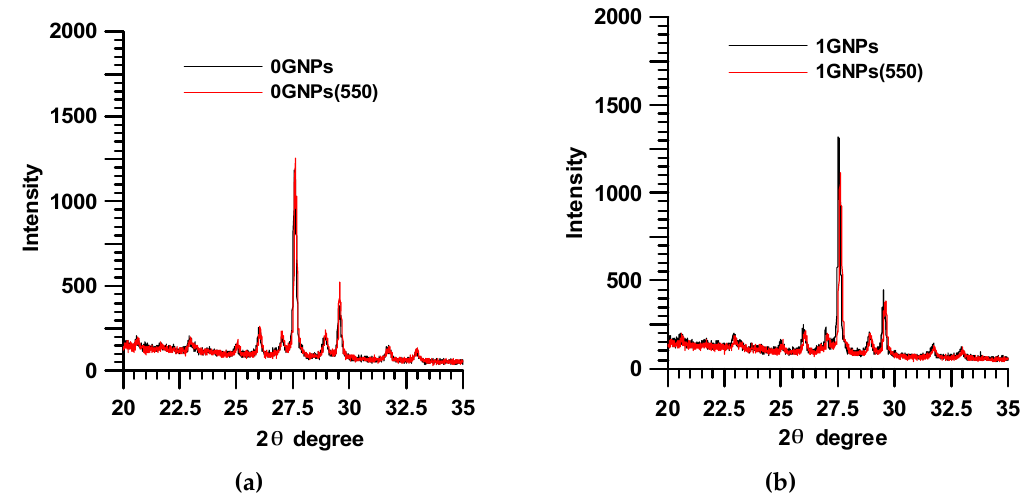
Figure 1. X-ray diffraction patterns of the samples 0GNPs (black trace) and 0GNPs (550) (red trace) ( a ); and 1GNPs and 1GNPs (550) ( b ).